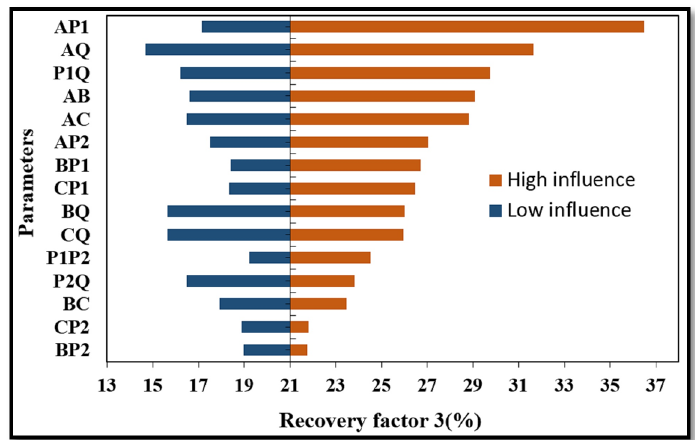
Figure 12. Summary of the results of the sensitivity analysis of coupled parameters on RF 3 showing the significance of each variable.